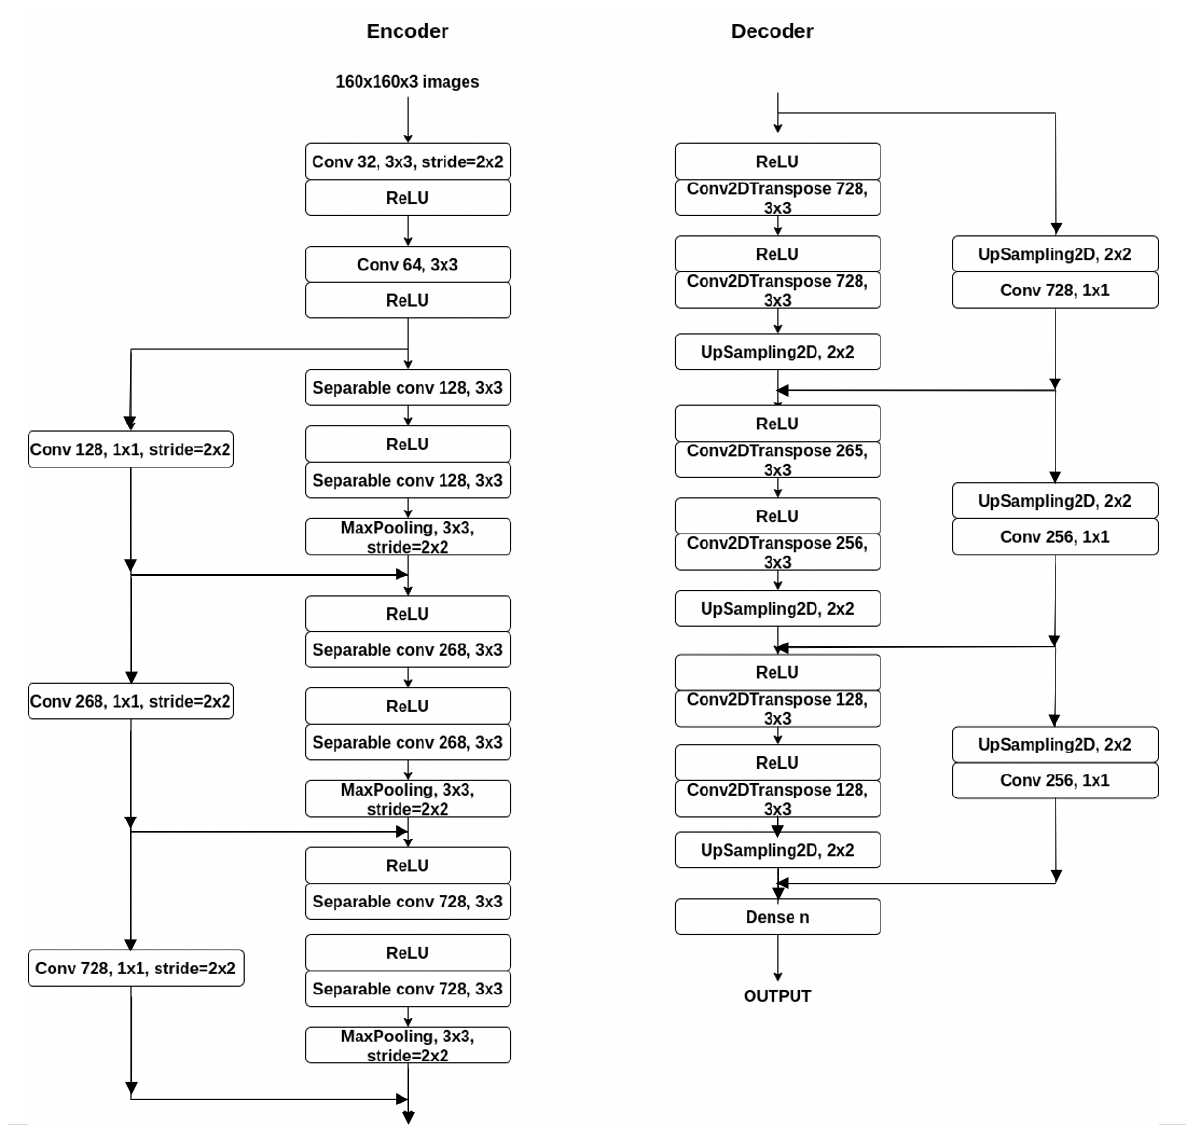
Figure 1. The proposed architecture, the decoding branch is almost symmetric to the encoding branch, except it reconstructs the values to the input image size using deconvolutions and upsampling layers.